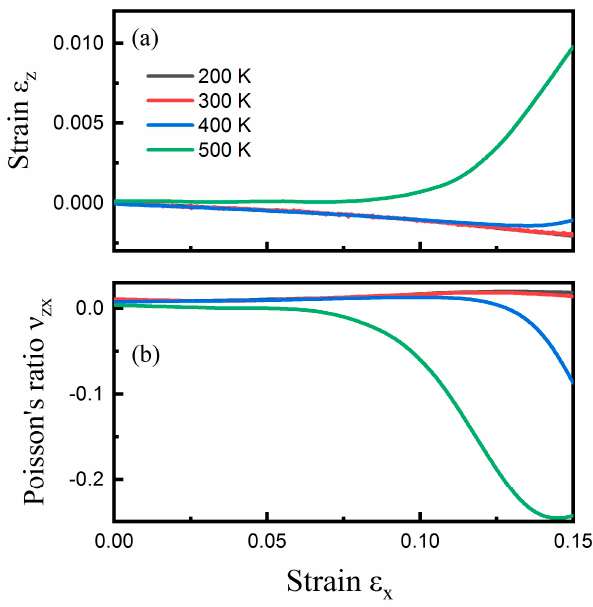
Figure 3. Temperature effect. The influence of temperature on the positive–negative Poisson’s ratio transition for CHC subjected to uniaxial tensile tests in the zigzag (x) direction. ( a ) Engineering strain ε z versus ε x at temperatures ranging from 200 to 500 K. ( b ) The corresponding ν zx for CHC at different temperatures.